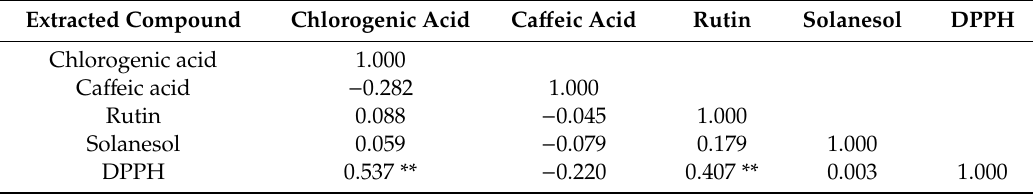
Table 5. Correlations between parameters of antioxidative activity in waste extracts. Extracted Compound Chlorogenic